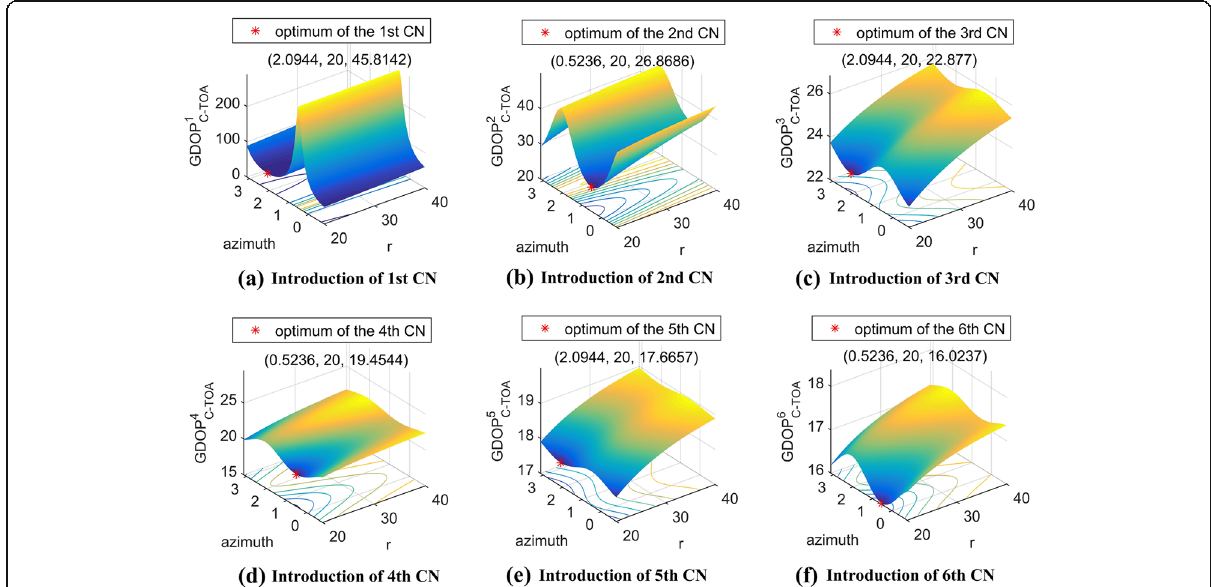
Fig. 6 Performance of partial exhaustive method towards AOA-based system in environment 2. a Introduction of first CN. b Introduction of second CN. c Introduction of third CN. d Introduction of fourth CN. e Introduction of fifth CN. f Introduction of sixth CN